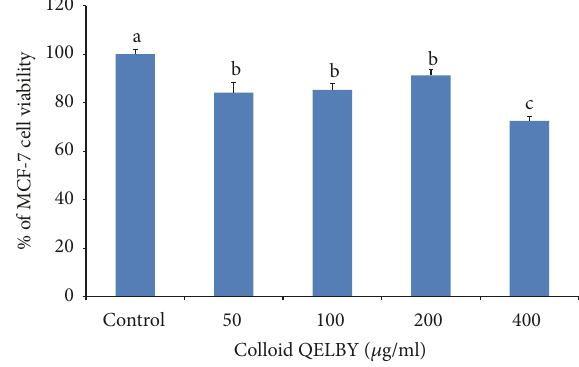
Figure 16: The effect of the QELBY colloid on the viability of MCF-7 breast cancer cells. The QELBY colloid was prepared by mixing with 1% of QELBY power and DMEM and centrifuged at 3,000 rpm. A different amount of the supernatant was used for the preparation of DMEM media. Data are mean ± SD (𝑛 = 4) . Means with different superscript are significantly different at 𝑝 < 0.05